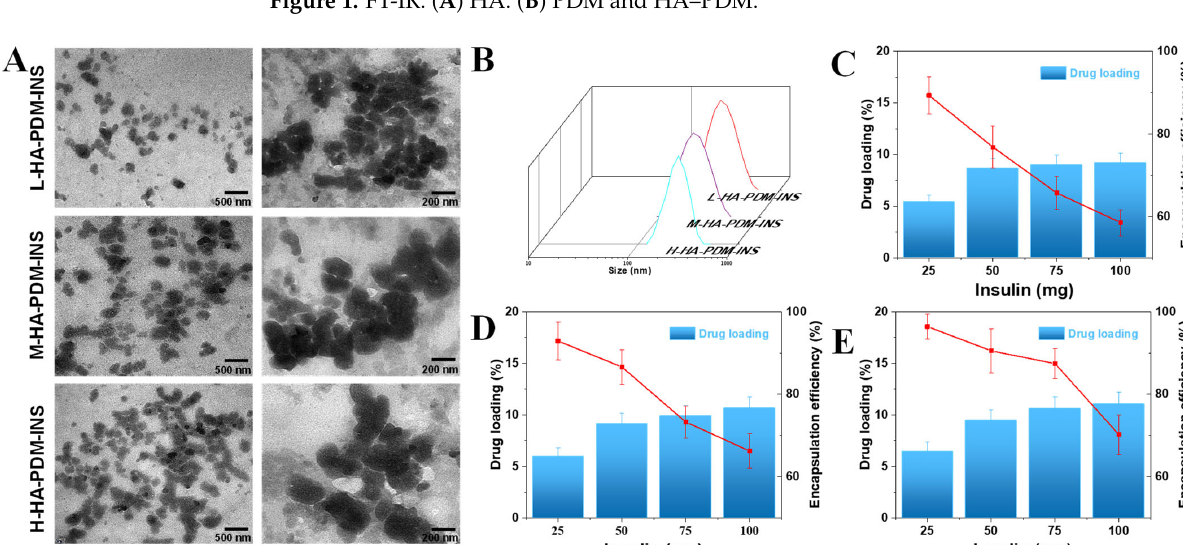
Figure 2. Characterizing data on the NPs. ( A ) TEM images of NPs, scale bar = 500 or 200 nm. ( B ) Dynamic light scattering of HA–PDM–INS. Drug loading and encapsulation efficiency of L ‐ HA– PDM–INS ( C ), M ‐ HA–PDM–INS ( D ), and H ‐ HA–PDM–INS ( E ) (X ± SD, n =